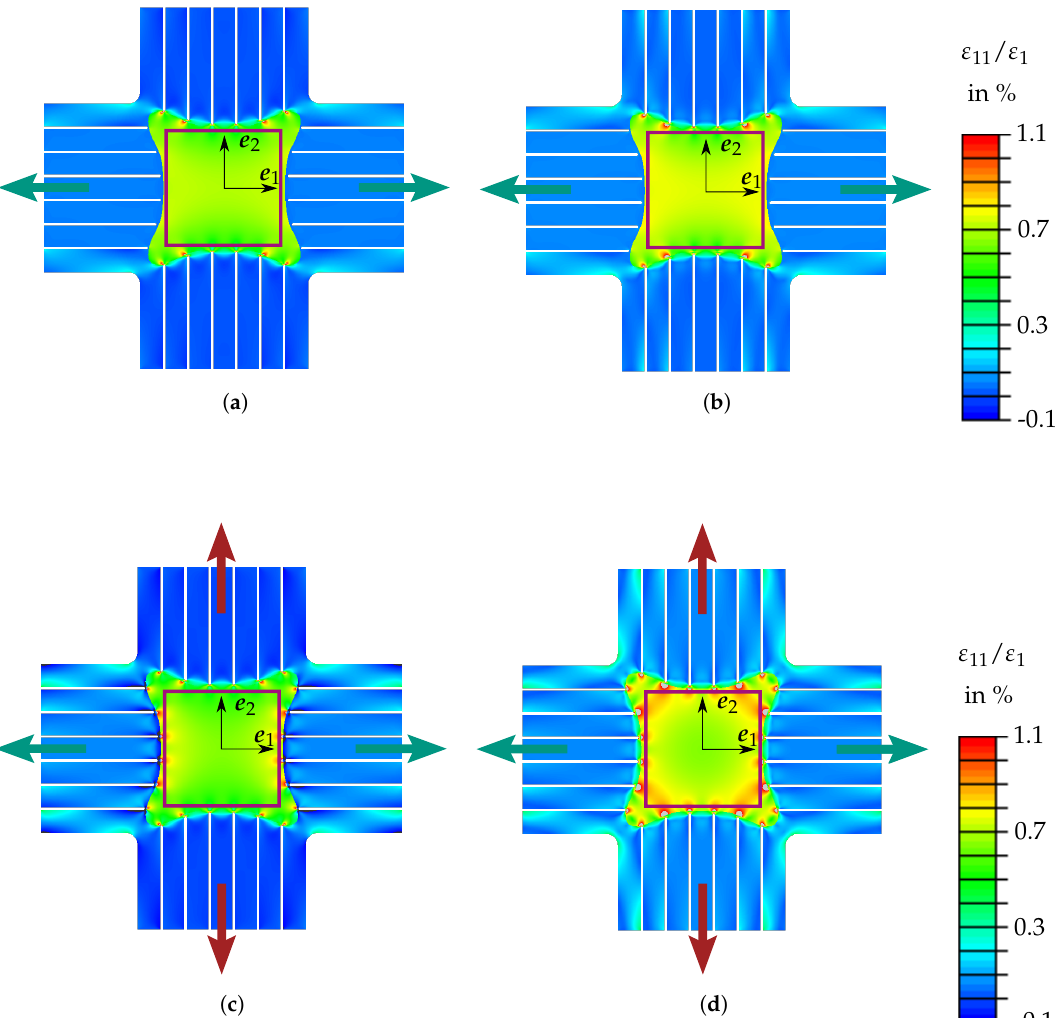
= 0.27%. The strain fields 11